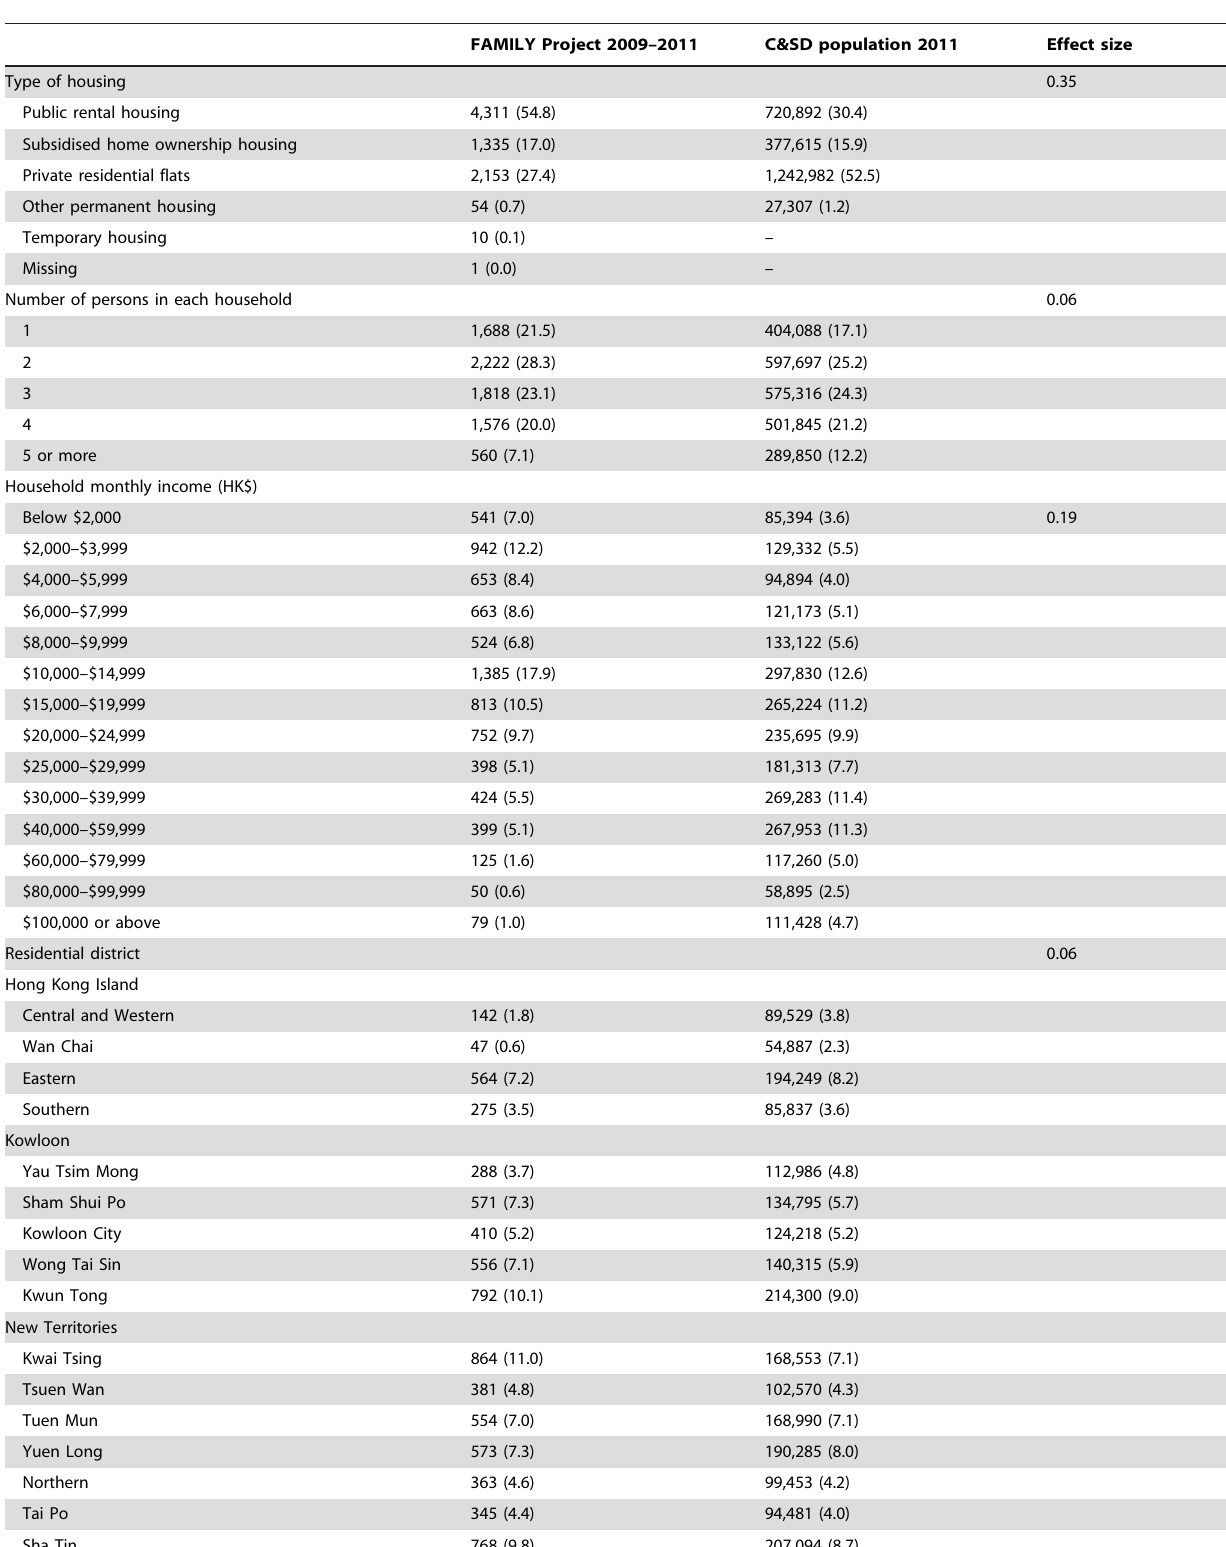
Table 1. Representativeness of sample at household level (Number,